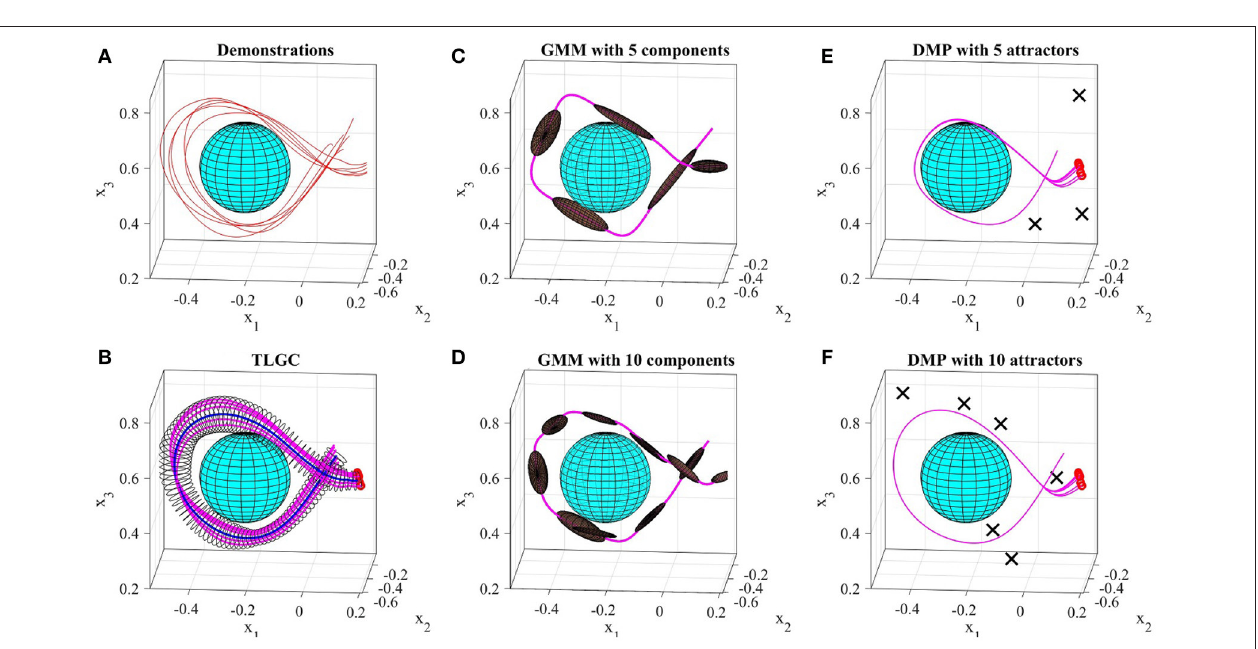
FIGURE 12 | Results of the comparison between GMM, DMPs, and TLGC in section 5.3.2 (A) demonstrations (B) GC and five reproductions, (C,D) GMM with five and ten components, respectively, (E,F) DMPs with five and ten attractors, respectively and five